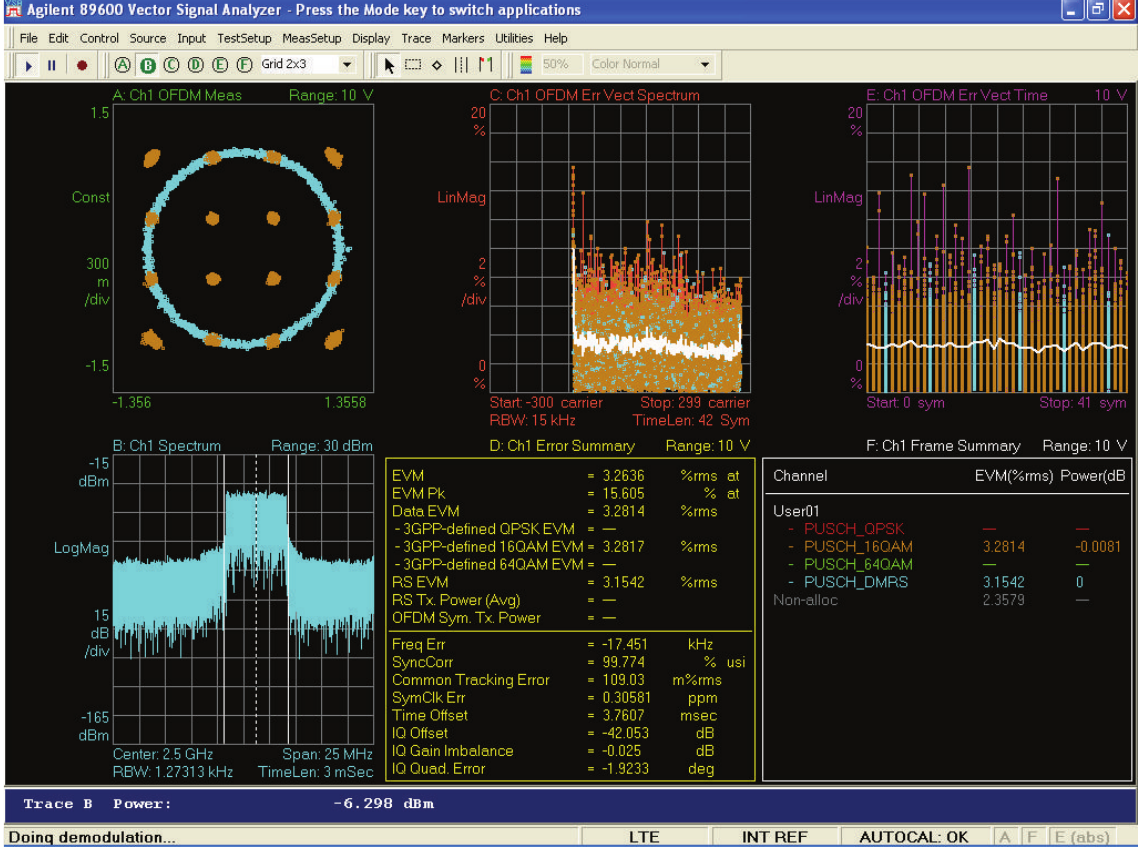
Figure 12: Vector signal analyzer LTE uplink screen snapshot: 16QAM PUSCH data (yellow) and PUSCH reference signals (light blue) constellation for one user at +21dBm output power with 3.1% rms